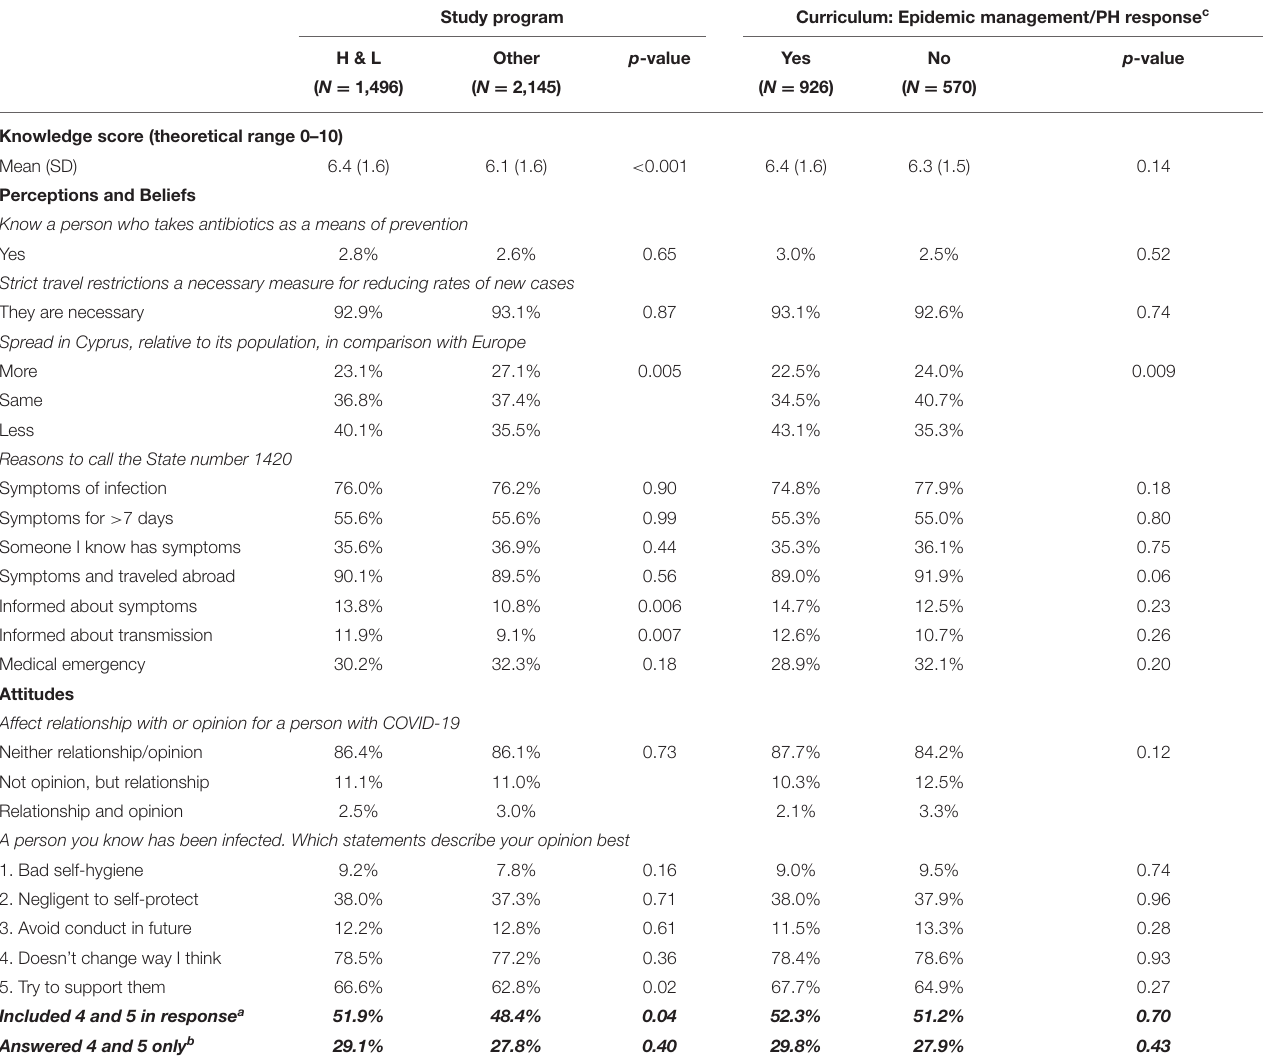
TABLE 3 | Perceptions, beliefs, and attitudes by study program ( N = 3,641) and whether curriculum covered epidemic management ( N = 1,496). Study program Curriculum: Epidemic management/PH response